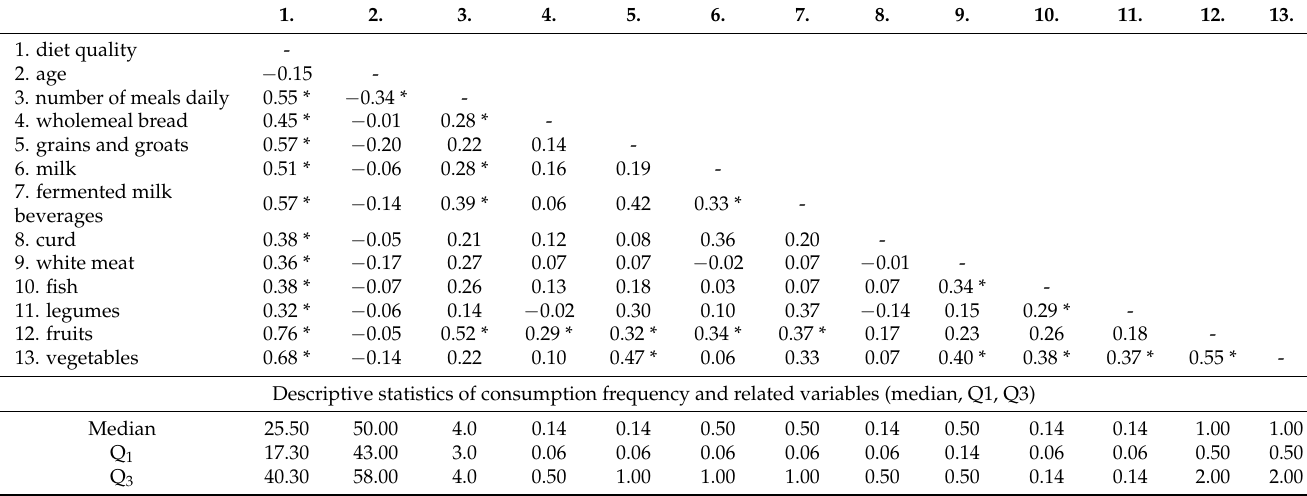
Table 2. Determinants of diet quality of masters athletics from